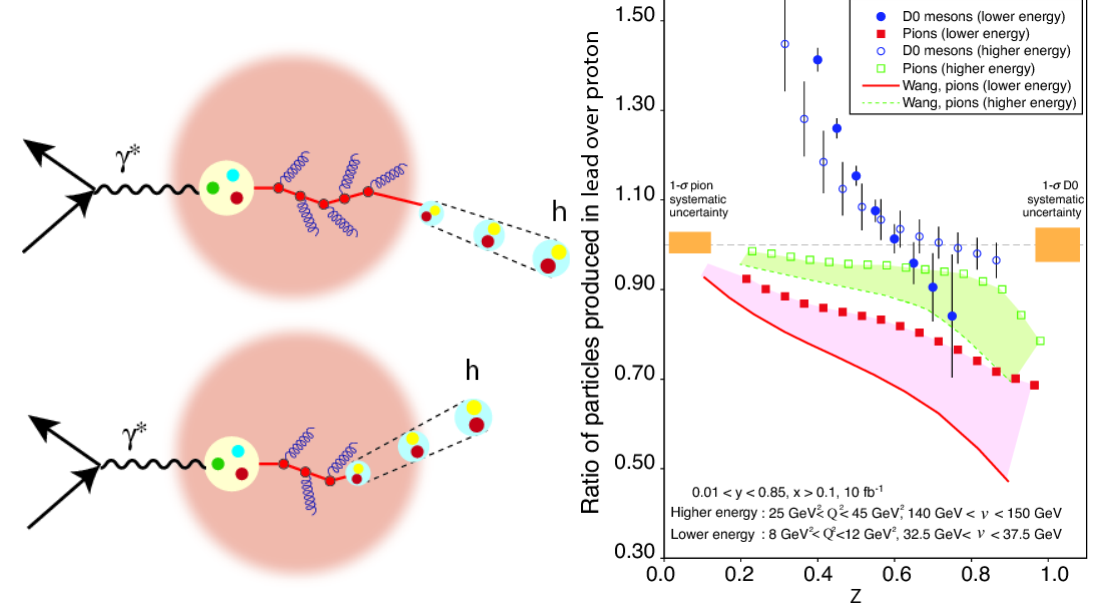
Figure 15. Left : Hadronization schematic illustrating the interaction of a parton moving through cold nuclear matter: the hadron is formed outside (top) or inside (bottom) the nucleus. Right : Ratio of semi-inclusive cross section for producing a pion (red) composed of light quarks, and a D 0 meson (blue) composed of heavy quarks in e-Pb collisions to e-d collisions, plotted as function of z, the ratio of the momentum carried by the produced hadron to that of the virtual photon ( γ ∗ ), as shown in the plots on the left; figures and descriptions taken from